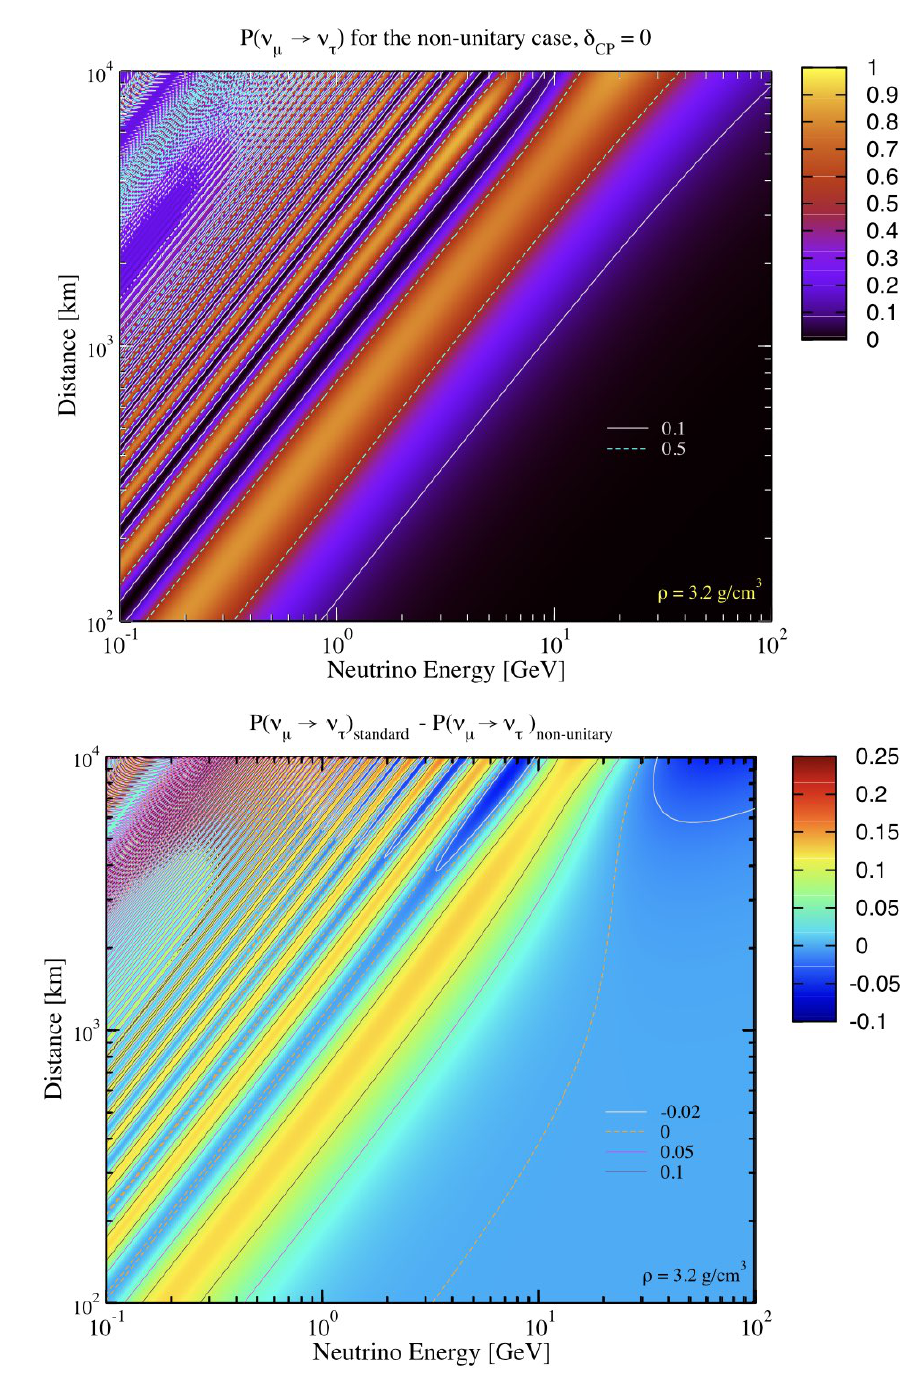
Figure 2 . In the upper panel (a), presented is the iso-contour of P ( (cid:23) (cid:22) ! (cid:23) (cid:28) ) (0) space. In the lower panel (b), the iso-contour of the di(cid:11)erence (cid:1) P ( (cid:23) (cid:22) ! (cid:23) (cid:28) ) (cid:17) P ( (cid:23) (cid:22) ! (cid:23) (cid:28) ) standard (cid:0) P ( (cid:23) (cid:22) ! (cid:23) (cid:28) ) (0) is presented. The parameters used are the same as in (cid:12)gure 1. non-unitary